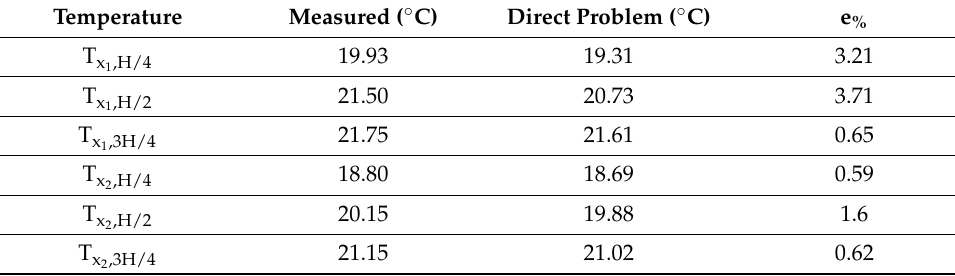
Table 5. Measured temperatures in wells 1 (x 1 ) and 2 (x 2